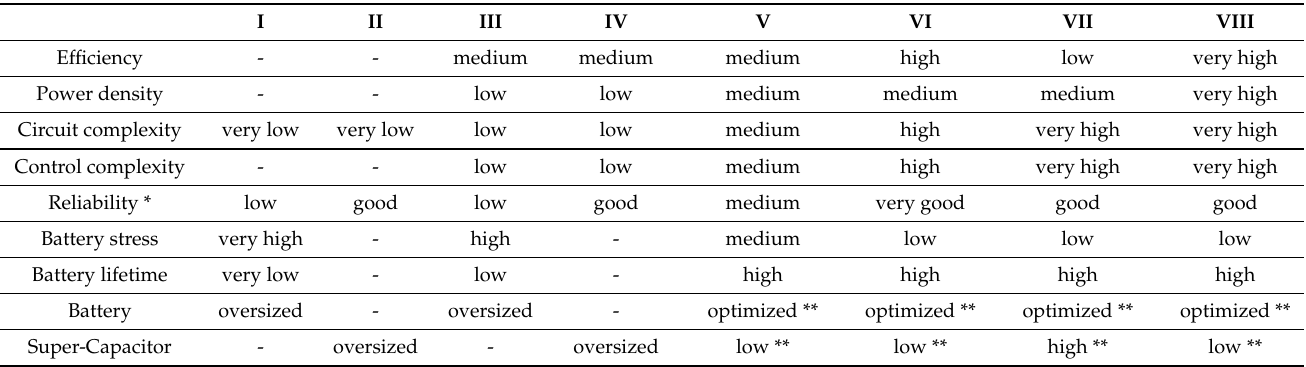
Table 17. Qualitative comparison of the different ESS